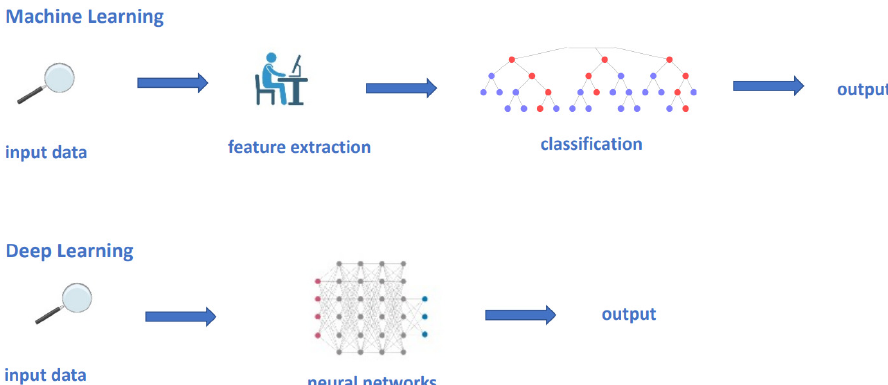
Figure 2. Conventional machine learning and deep learning models. In a conventional machine learning process, an expert need to define the meaningful features to be processed into the statistical model, which will work out the output, based upon the selected features. Contrastingly, in deep learning models, the manual definition of features is not needed; each network hierarchy automatically extracts critical features from a subset of data.